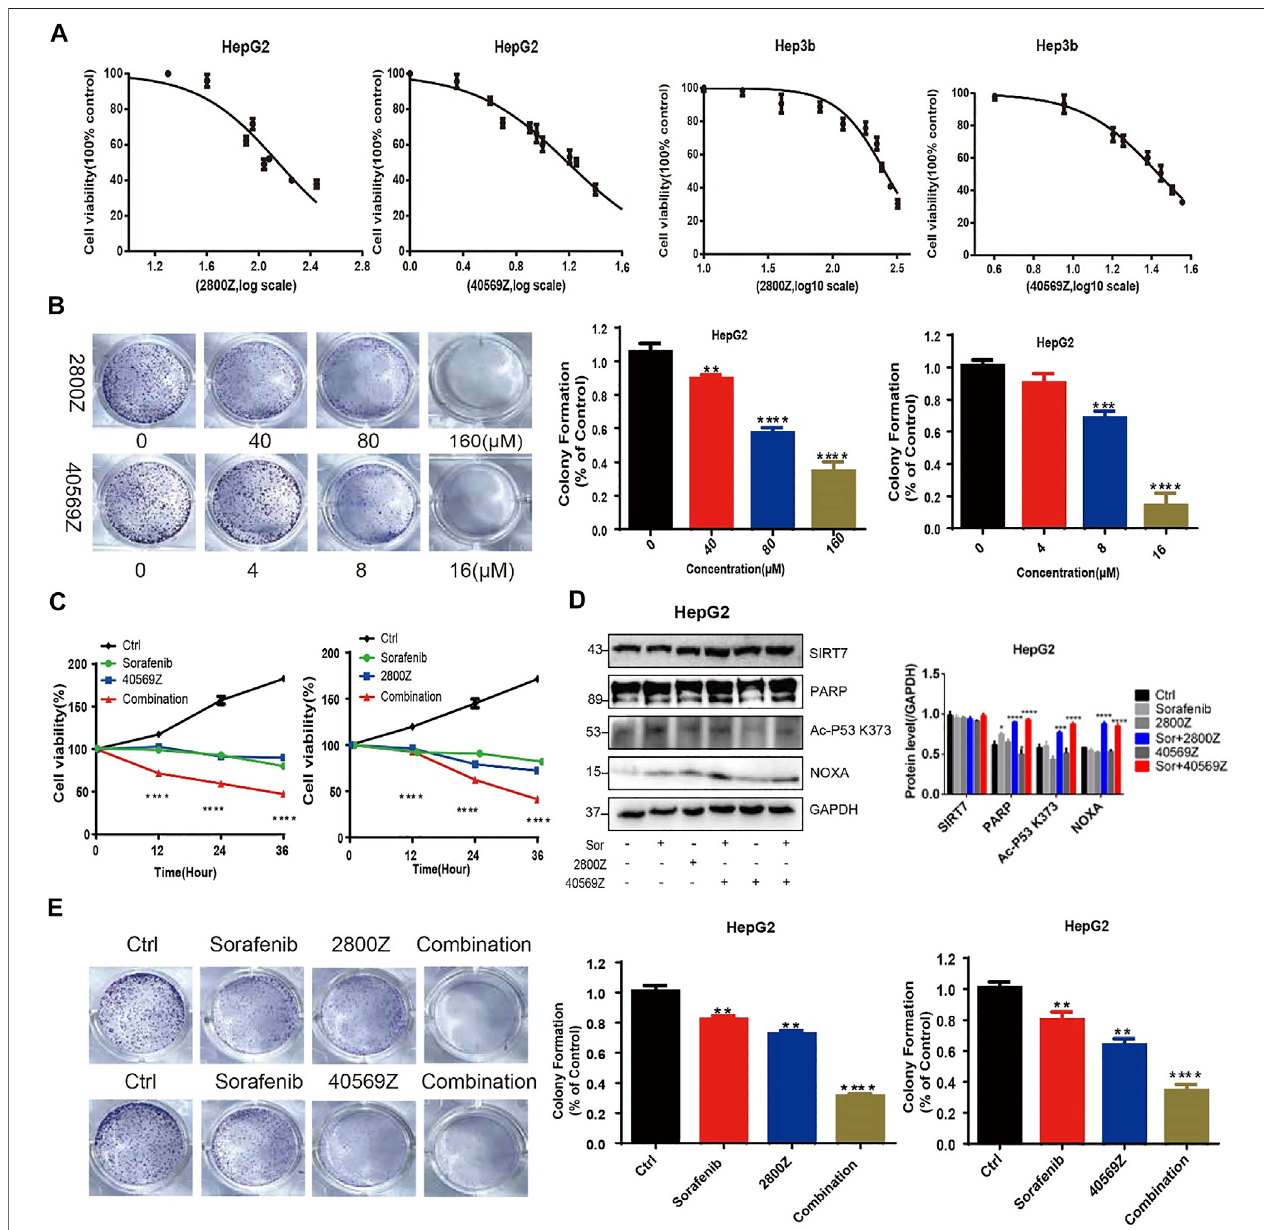
FIGURE 5 | In vitro assessment of anticancer effects of 2800Z and 40569Z. (A) HepG2 cells were treated with a range of concentration of 2800Z or 40569Z, and cellviabilitywasassessed 24 haftertreatment byusingtheCCK8assay. (B) ColonyformationassayofHepG2cellswasuntreatedortreatedwith2800Zor40569Zina dose-dependent fashion for 5 days. Graphs show mean ± SEM of at least three independent experiments. ** p < 0.01, *** p < 0.001, **** p < 0.0001, one-way ANOVA. (C – D)HepG2cellsweretreatedwithsorafenib(4 μ M)intheabsenceorpresenceof2800Z(60 μ M)or40569Z(6 μ M),andcellviabilitywasassessedatvarioustime points as indicated by using the CCK8 assay (C) , and protein levels of SIRT7, PARP, acetyl-p53 K373, and NOXA were evaluated by WB (D) . Quanti fi cation of WB was determinedbydensitometry.Graphsshowmean ± SEMofatleastthreeindependentexperiments.* p < 0.05,*** p < 0.001,**** p < 0.0001,one-wayANOVA. (E) Colony formation assay of HepG2 cells was untreated or treated sorafenib (4 μ M) in the absence or presence of 2800Z (60 μ M) or 40569Z (6 μ M) for 5 days ** p < 0.01, **** p < 0.0001. All graphs show mean ± SEM of at least three independent experiments.